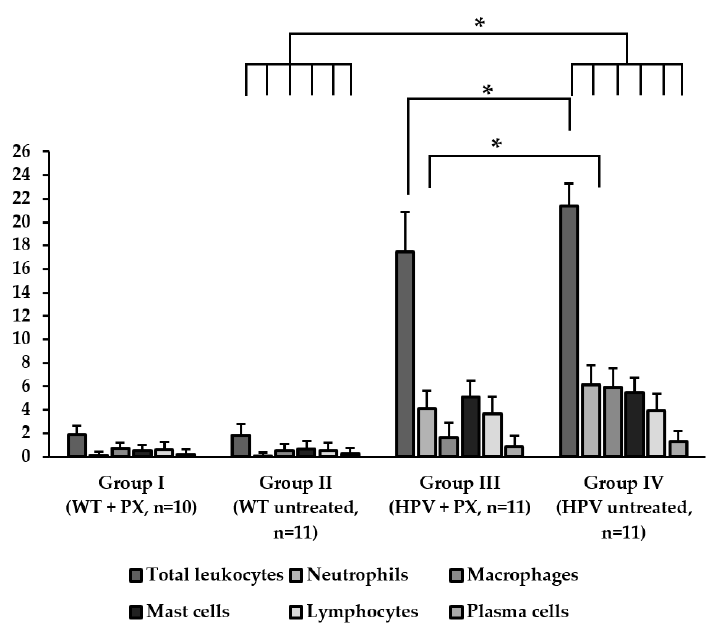
Figure 5. Total infiltrating leukocytes and specific leukocytic populations’ counts on healthy skin and HPV-induced lesions. Leukocyte counts were expressed as mean ± standard deviation.